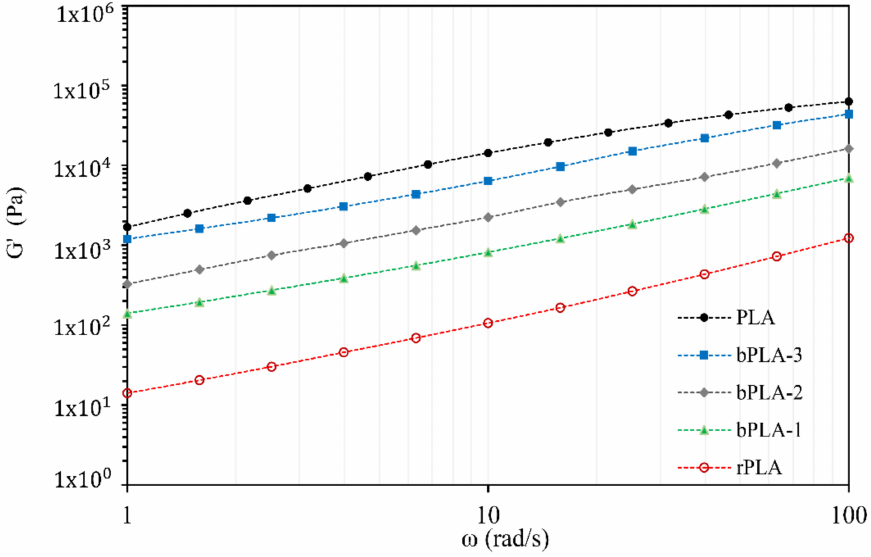
Figure 11. Storage modules G’ vs. frequency for r-PLA and bPLA